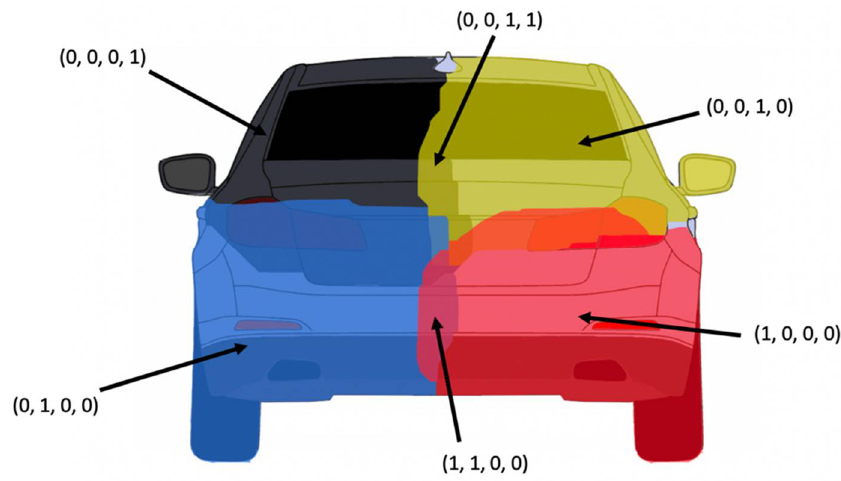
Figure 7. Object pixel coding, based on segmented quarters. Some pixels can belong to more than one quarter.